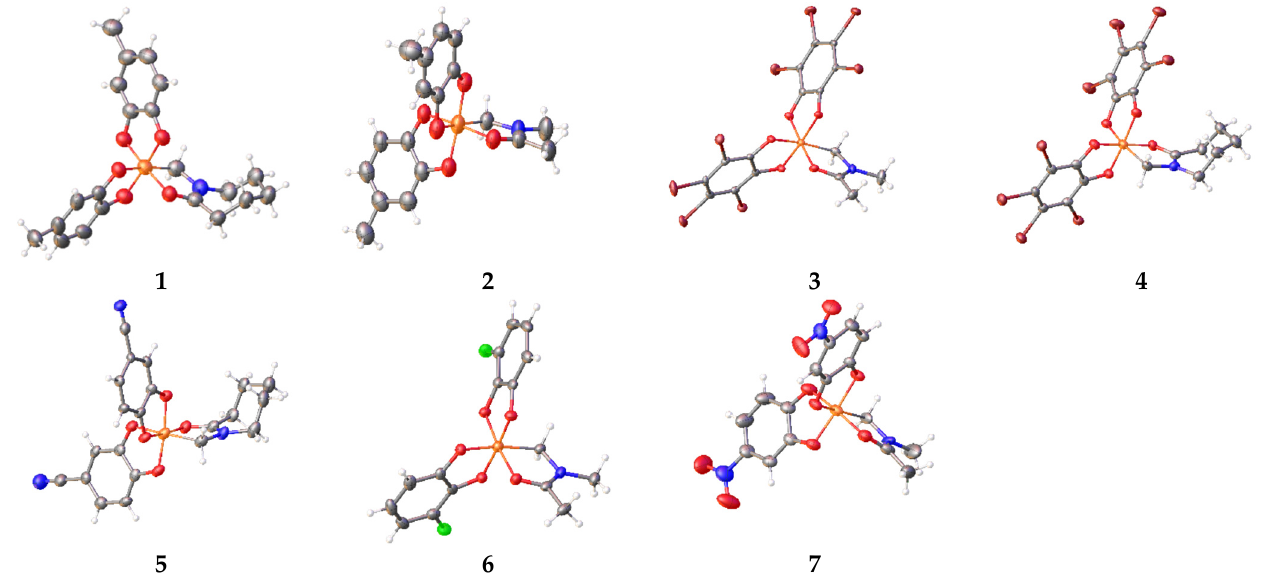
Figure 2. General view of. [Si IV L Cat x2 ] – anions in 1 – 7 in representation of atoms with thermal ellipsoids ( p = 50%). Hydrogen atoms are omitted. Color code: Br—brown; C—grey, F—green; N—blue; O—red; Si—orange.